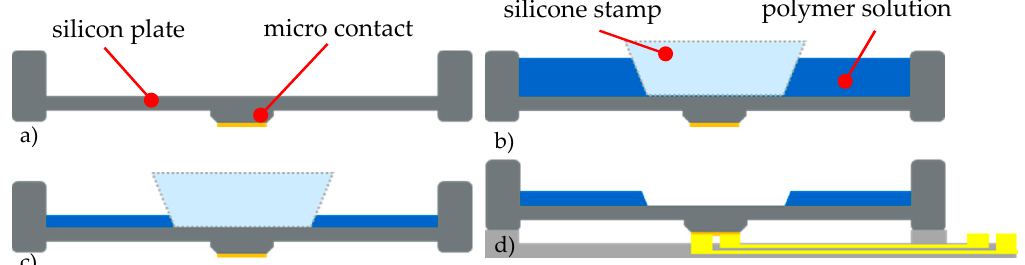
Figure 14. Patterning of the hydrogel layer atop the silicon bending plate by using a silicone stamp: ( a ) initial state, ( b ) silicone stamp attached to the bending plate, cavity filled with polymer solution, ( c ) after evaporation of the solvent from the polymer, ( d ) resulting hydrogel layer after the stamp was removed and the polymer was cross-linked 8 (adapted from Reference [7]).